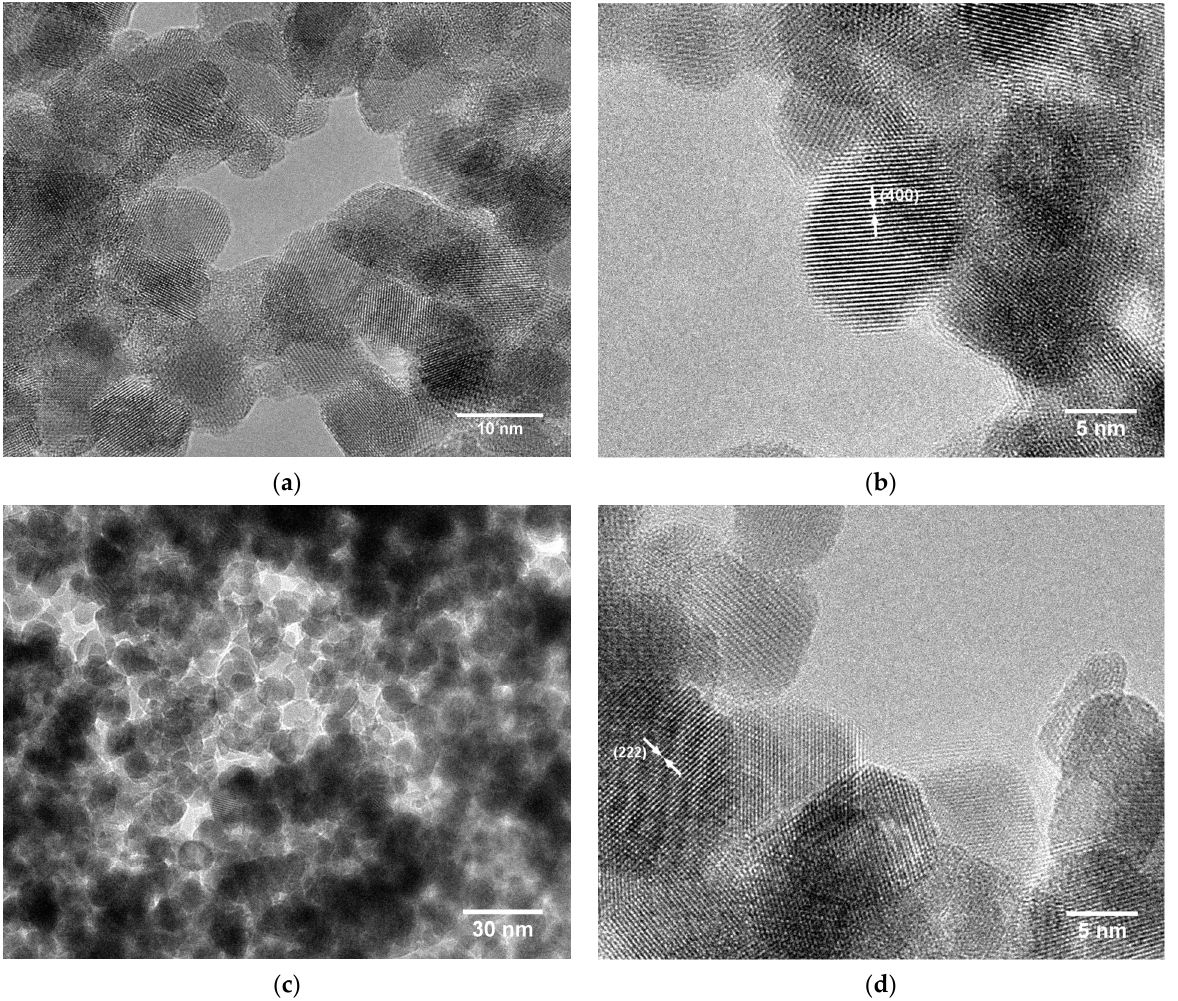
Figure 6. HRTEM micrographs of ITO aerogel A samples as obtained directly after CPD ( a , b ) and after annealing at 400 °C for 2 h in air ( c , d ) at di ff erent magni fi cations.